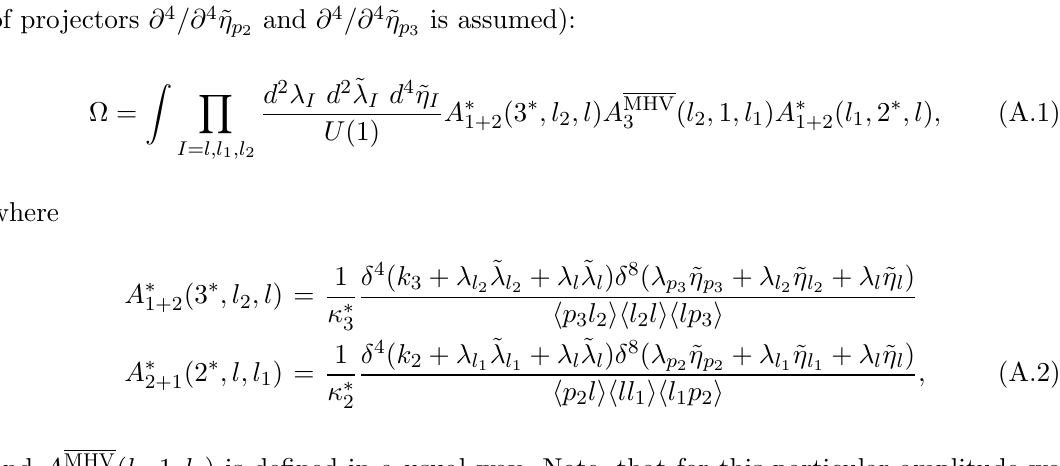
(1 + ; 2 (cid:3) ; 3 (cid:3) ) 1+2